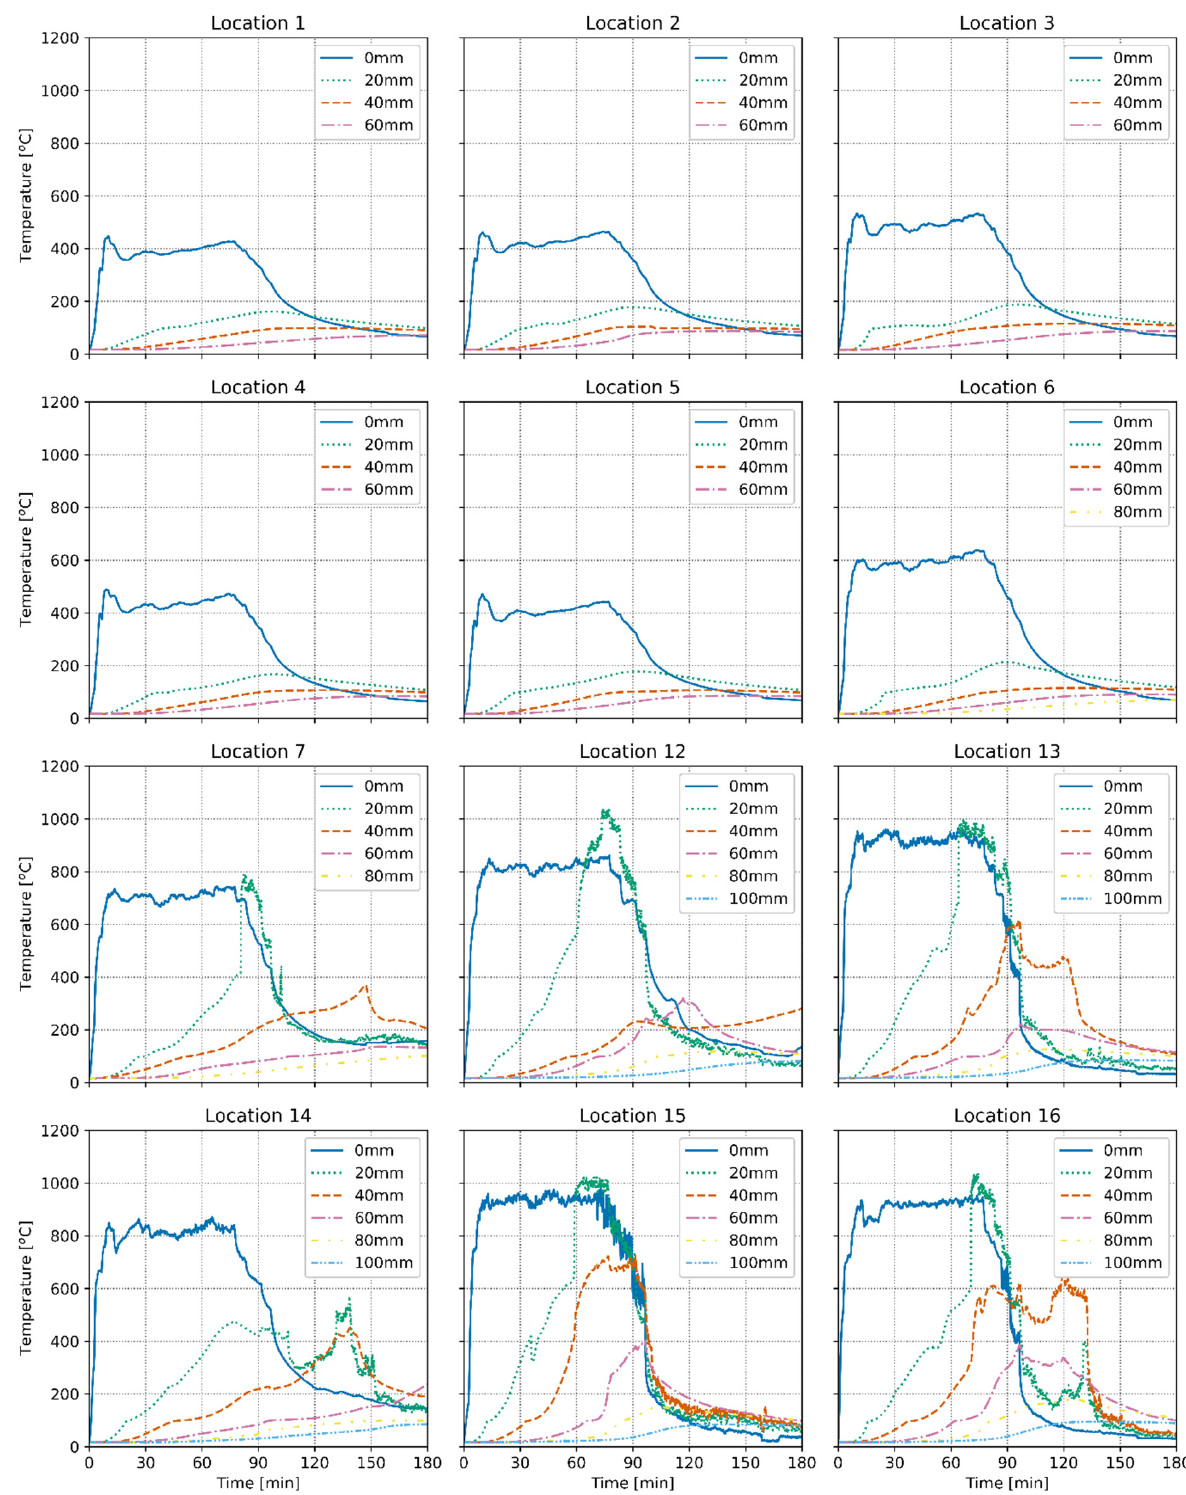
Figure 11. Surface and in-depth CLT temperatures for Experiment 2.